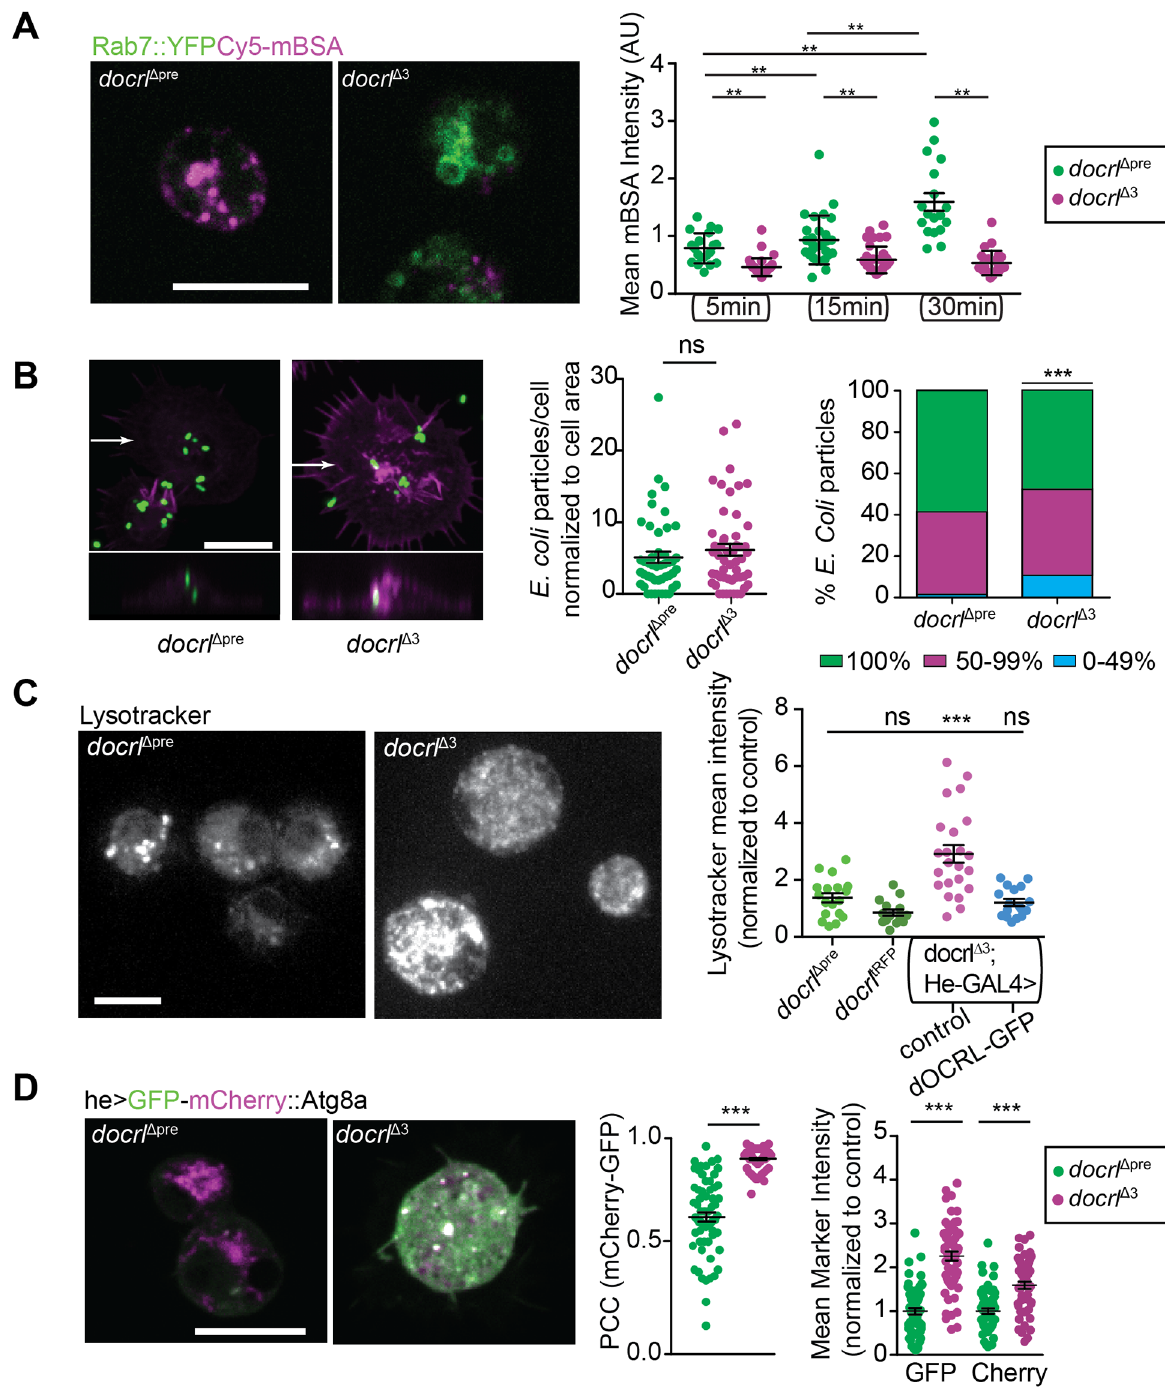
Fig 6. Aberrant endosomal compartment function in docrl mutants. (A) docrl mutant hemocytesexhibit defective scavenger receptor mediatedendocytosisof mBSA (magenta). (B) docrl mutant hemocytes are competent for phagocytosis. Images show 2D maximum intensity projectionof confocalstacks, showingmyr-mRFP-expressing hemocytesincubatedwith Alexa-488labeled E . coli . Lower panelsshow ZX projections taken at the plane marked by arrows in the respectiveprojections. Z sections show internalized E . coli . (Middle) Quantification of mean number of E . coli particles. (Left) Fraction of particles completelyengulfed by hemocytes. Data are presented as mean +/- SEM. (C) The structure and abundance of Lysotracker-positive (acidified)compartments is altered in docrl mutants, and rescuedcell-autonomouslyby re-expression of docrl . Image shows 2D maximum intensity projectionof confocal stacks. (D) docrl mutants exhibit defective accumulation of autophagiccompartments, marked by GFP-mCherry-Atg8a (GC::Atg8A).